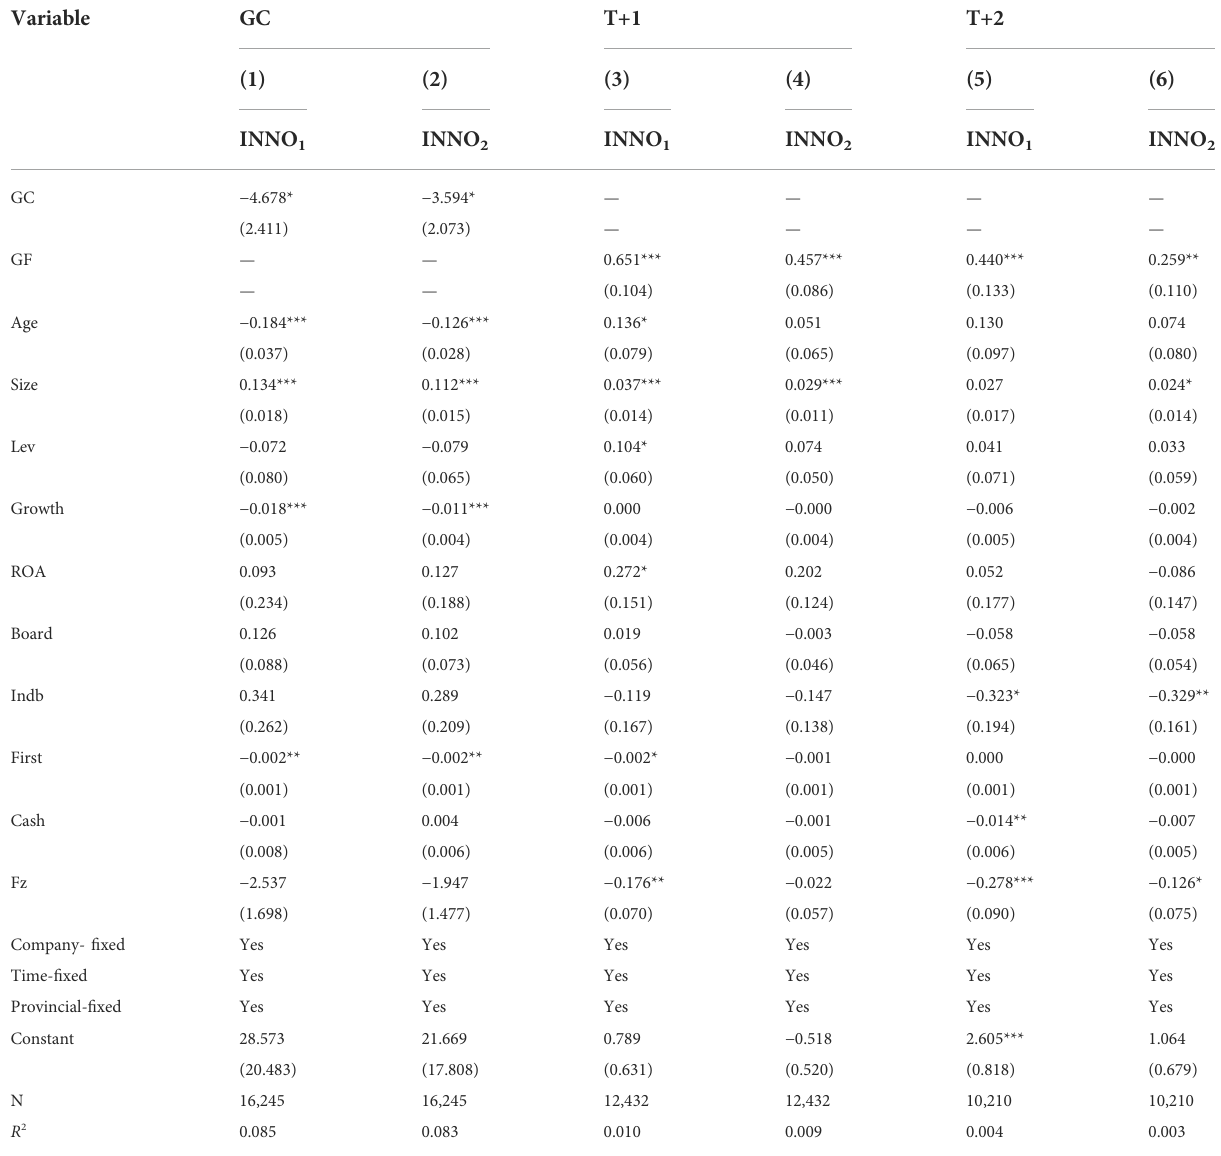
TABLE 5 Robustness test: Change the measurement method of variables.